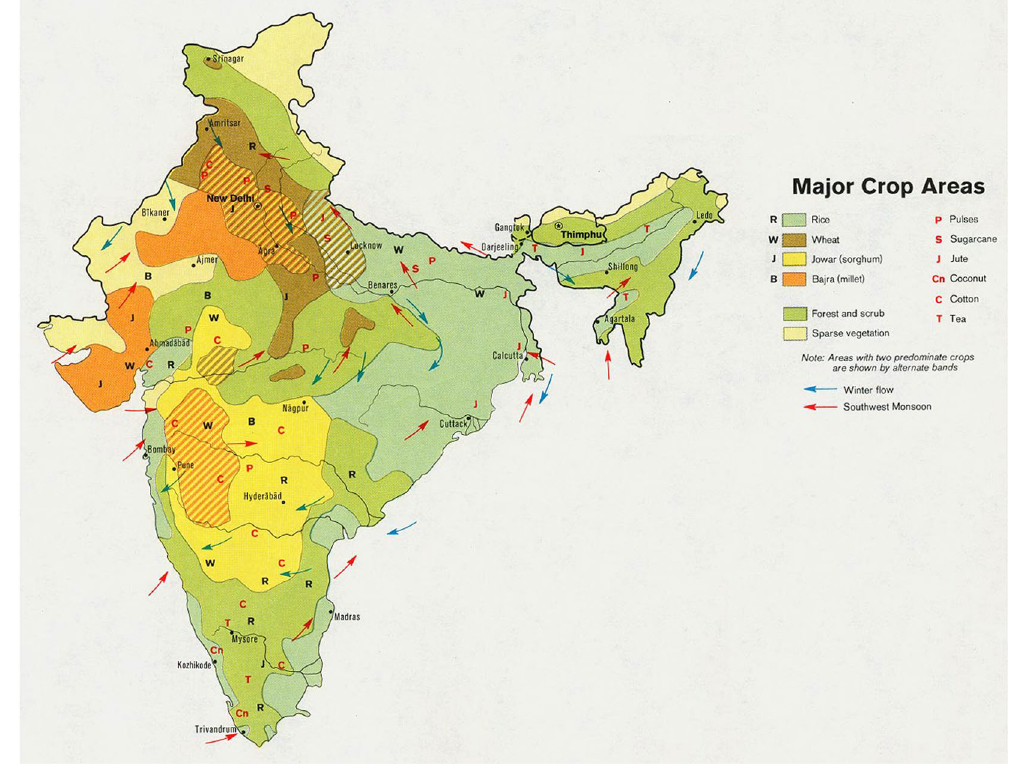
Figure 9. The major crop growing areas of India. Growing regions for the primary crop of rice (light green) and sorghum (yellow) lie in the northeast to southwest oriented zone of cooling (or reduced warming) depicted in Figs. 2–4. (University of Texas Libraries,